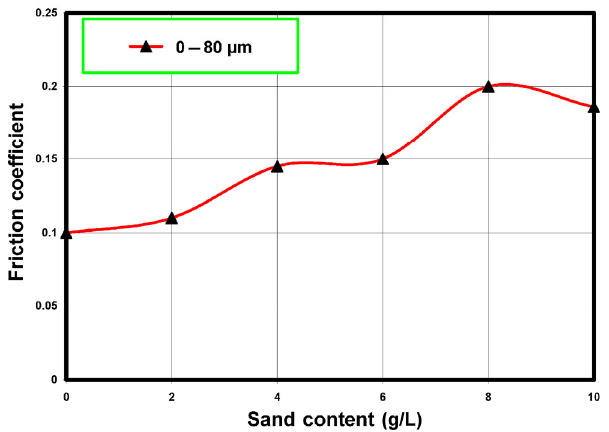
Fig. 3 Effect of sand contamination in lubricant on friction for sand particles of size 0–80 µm .